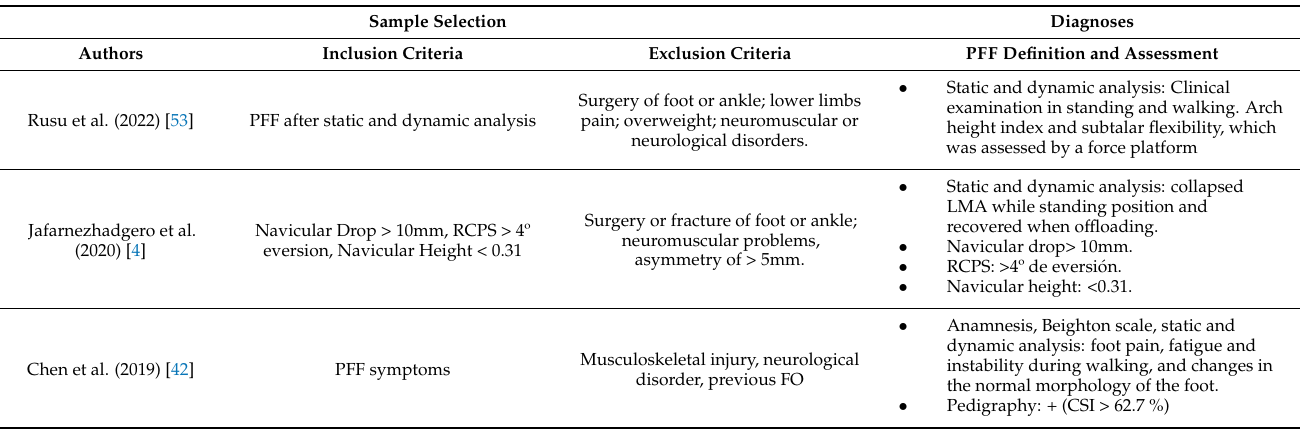
Table 2. Sample selection and